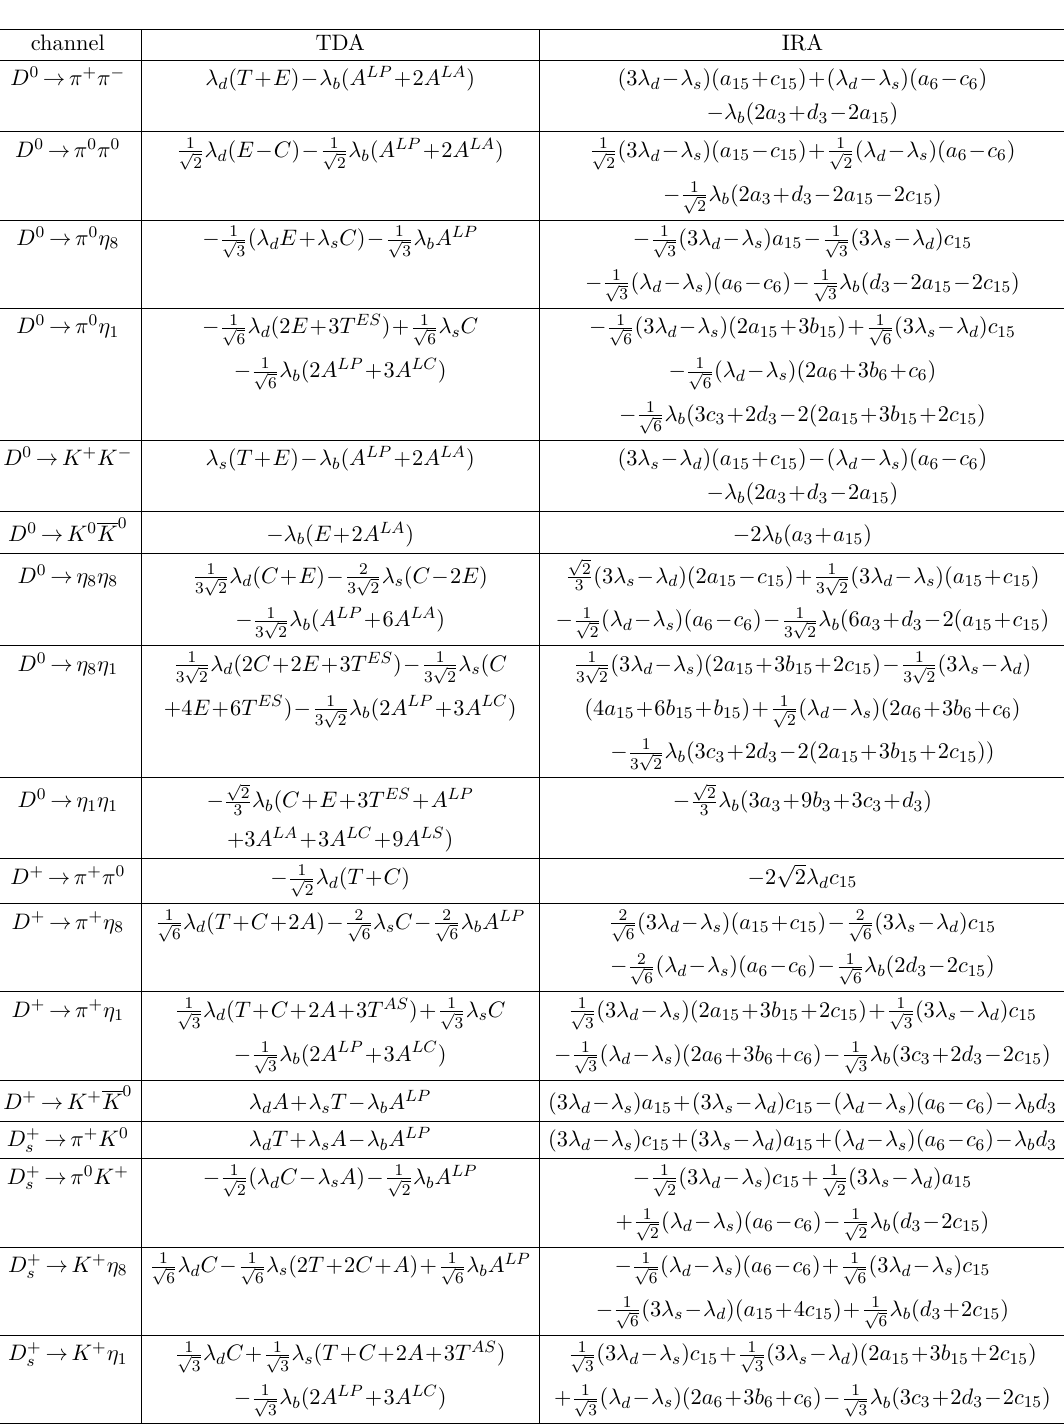
= V ∗ V ud , λ s = V ∗ V us , λ b = V ∗ V ub and λ b = − ( λ d + λ s ) . The redefini- d cs cd cb